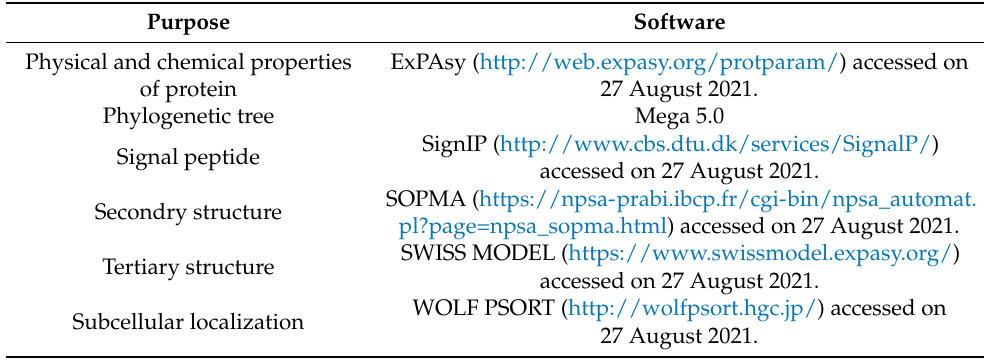
Table 1. Bioinformatics analysis software and website used in this